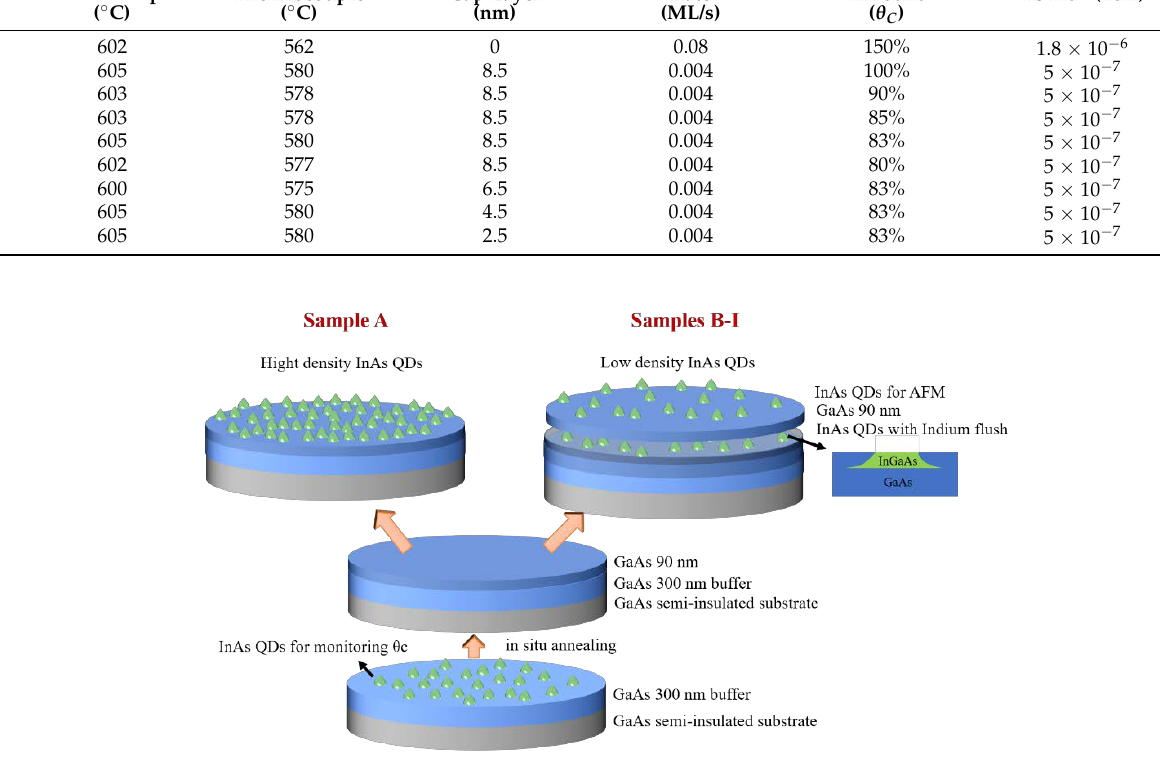
Figure 1. Schematic process of the quantum dot (QD) growth: Sample A was designed to fabricate single layer of high density InAs QDs for the measurement of temperature distribution of the three-inch wafer, while Samples B–I were designed to optimize parameters to achieve three-inch wafer-scale low density InAs QDs.